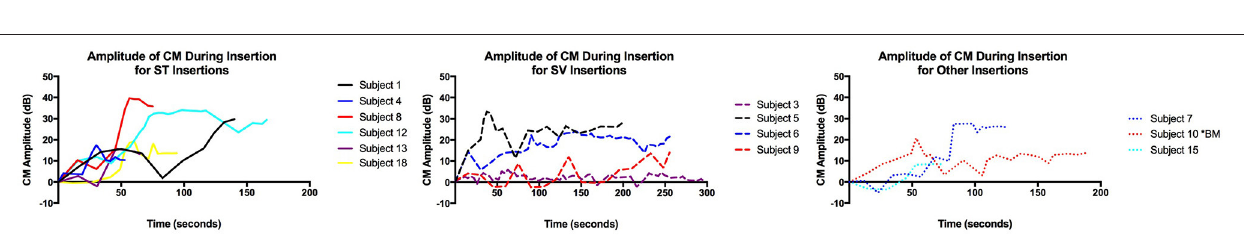
correlate significantly with postoperative audiometric thresholds;